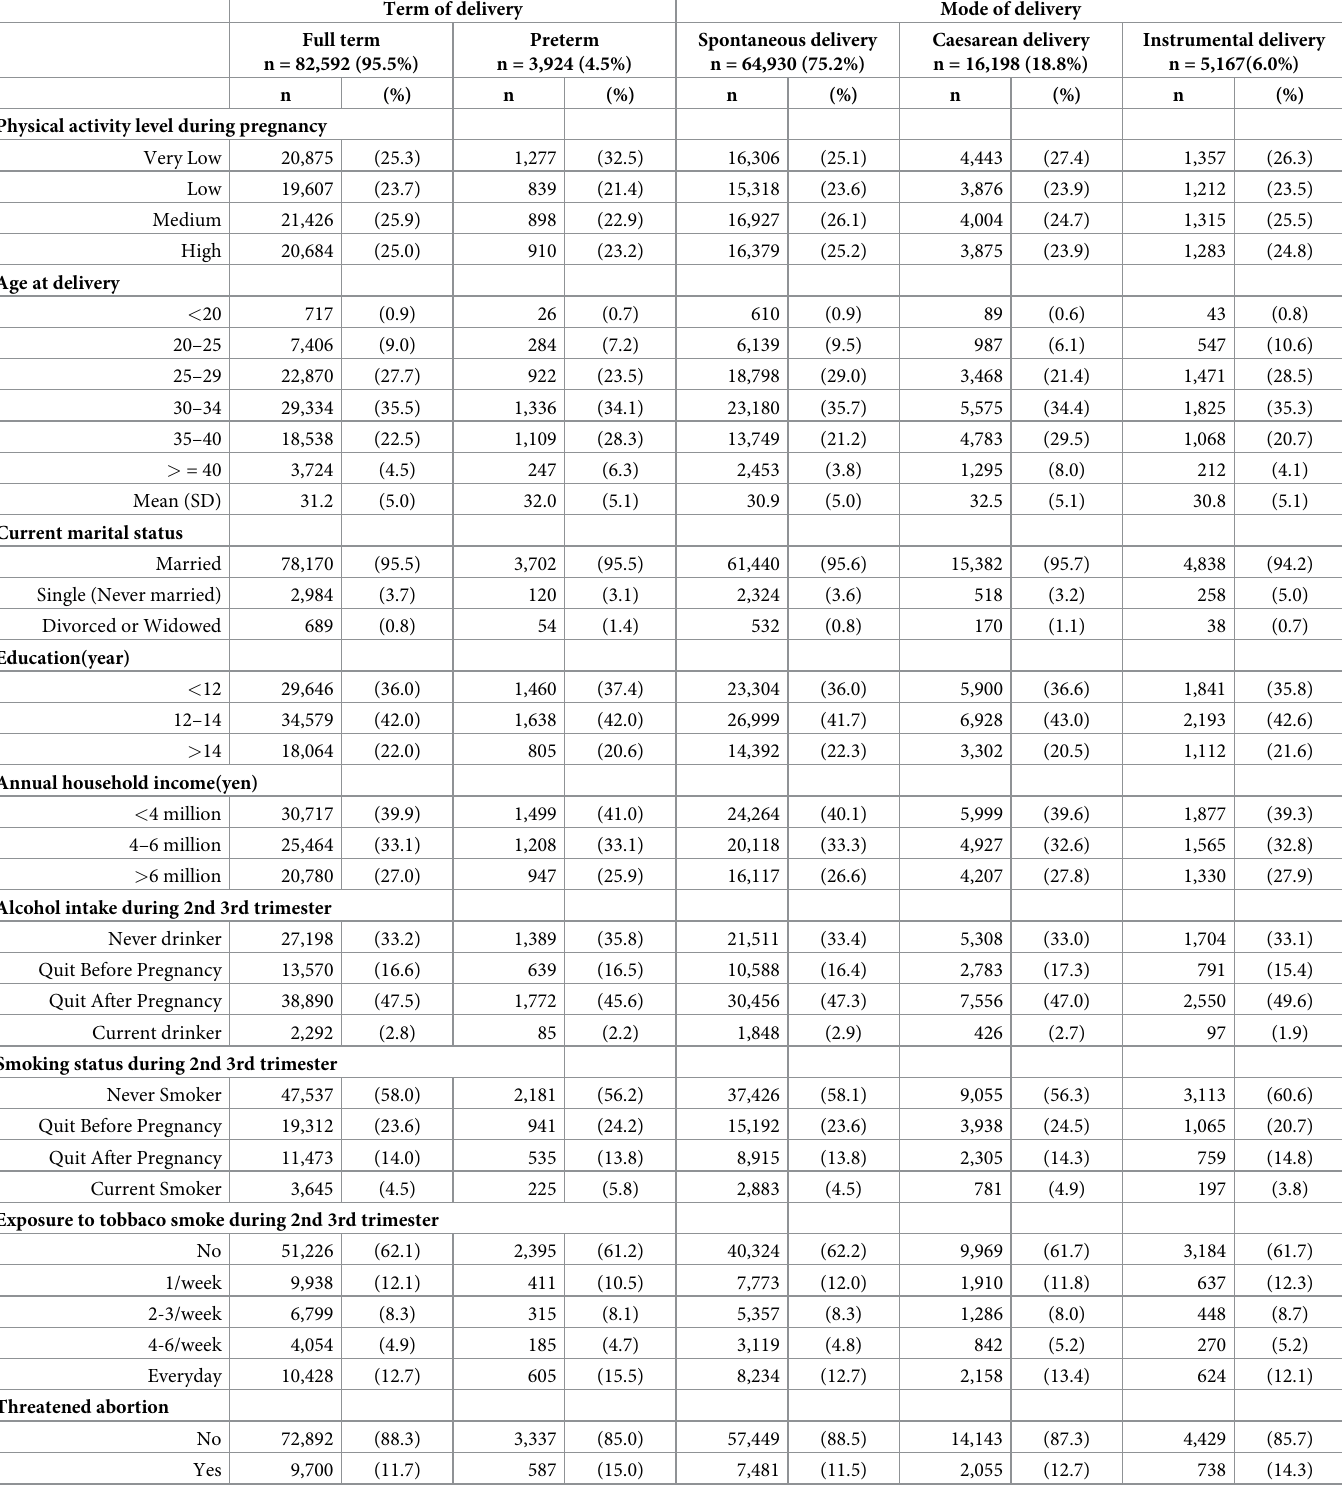
Table 2. Maternal characteristics according to the term of delivery (n = 86,516) or the mode of delivery (n =